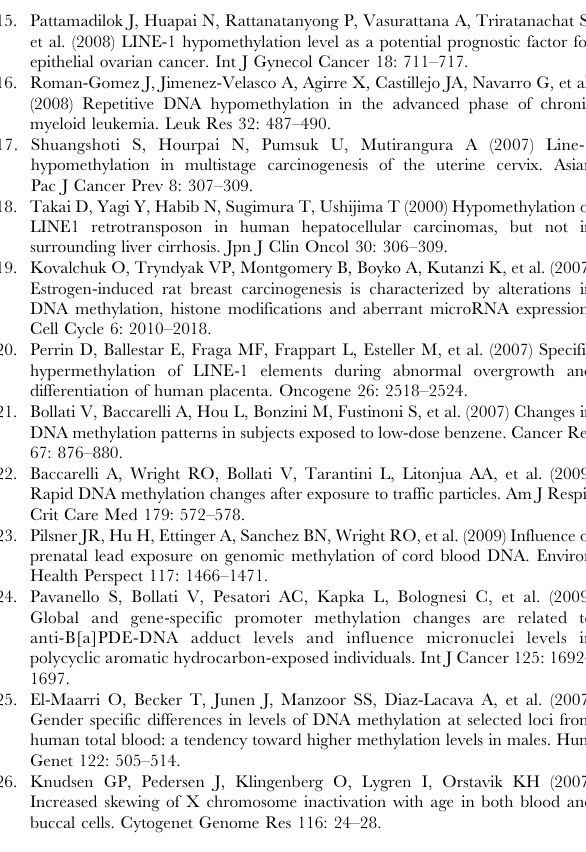
82% at position 1 (CpG15) and end with 0% at position 7 (CpG21). Figure S4 A) Methylation value distribution in the six experimental groups before and after correction. In every group, the number of males and females is also shown. B) Age distribution in the six experimental groups. In every group the number of males and females is also shown. Table S1 Primer sequences used in this study. Table S2 Summary findings of several studies that analyzed LINE-1 global methylation in healthy human